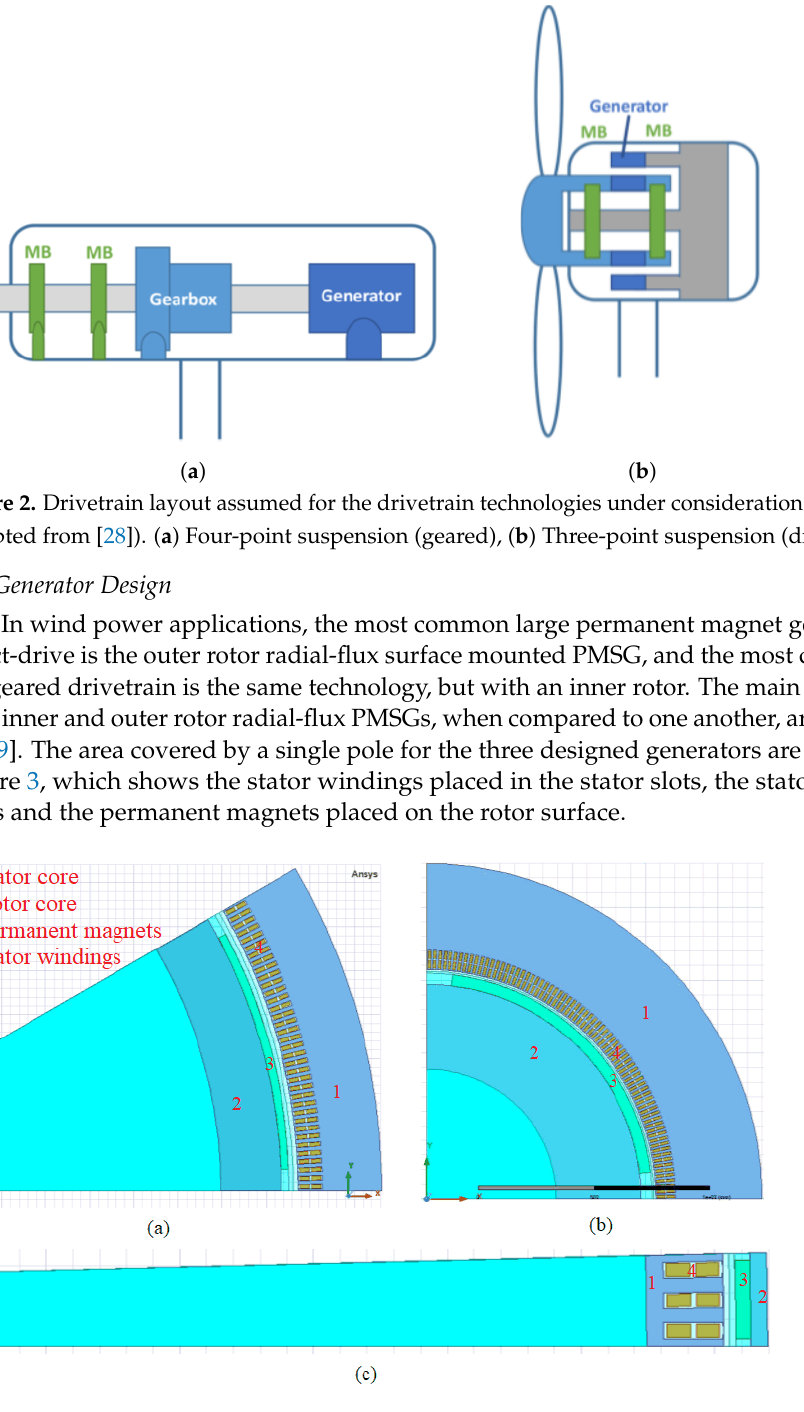
Figure 3. PMSG layout. ( a ) medium-speed (inner rotor), ( b ) high-speed (inner rotor), ( c ) direct-drive (outer